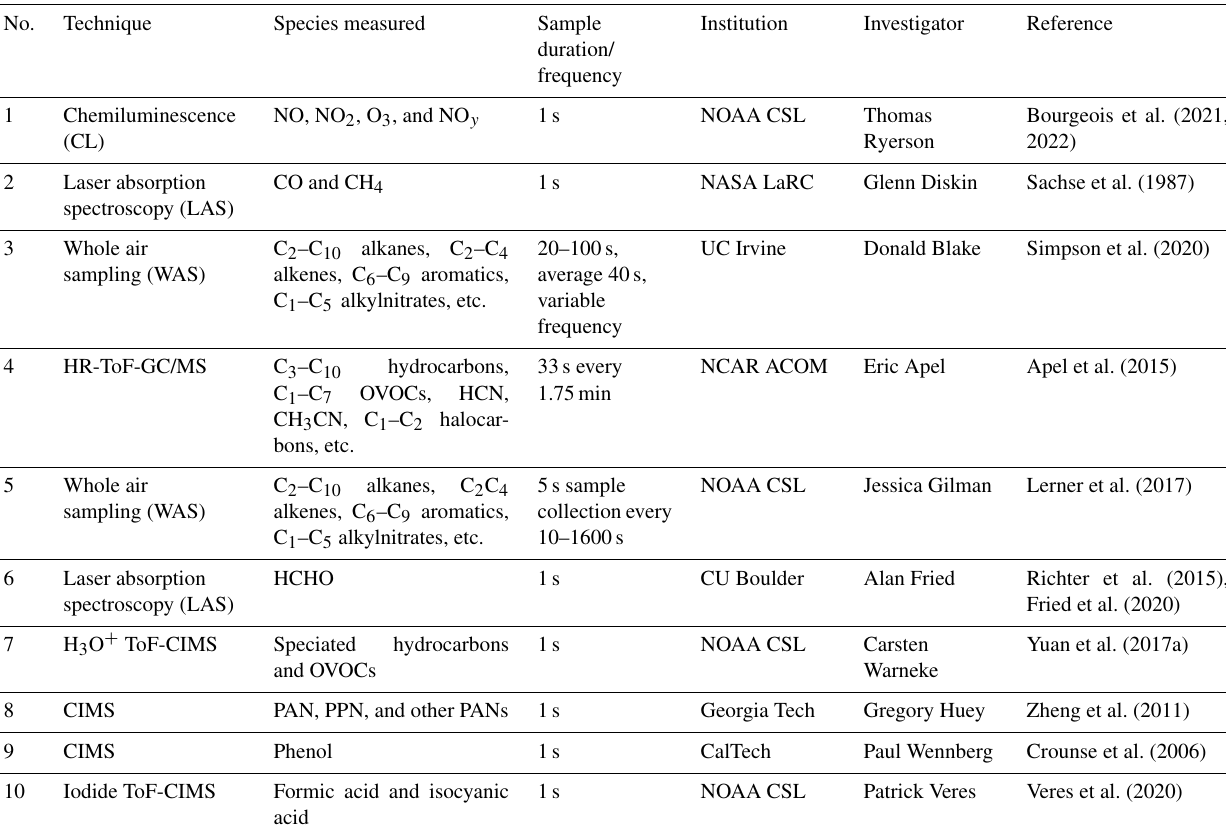
Table 1. Summary of measurements a